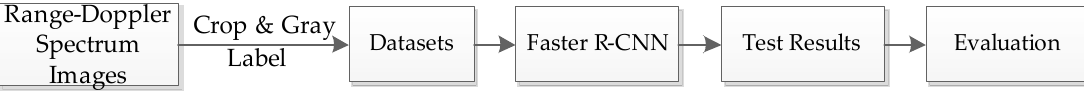
Figure 2. The procedure of the proposed algorithm to detect the clutter and interferences.